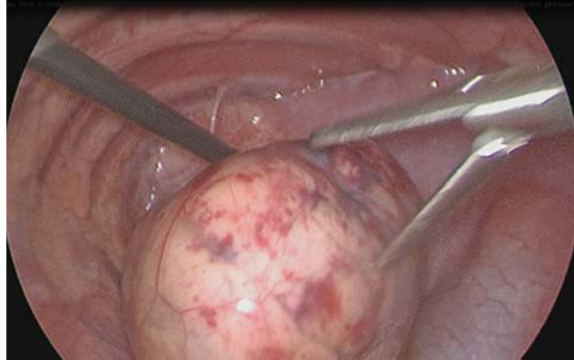
Fig. 2 Reduction of intrathoracic kidney.